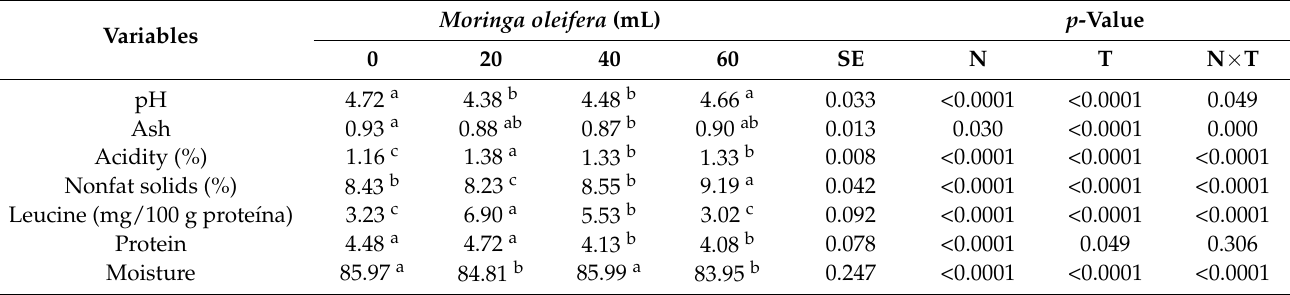
Table 2. Chemical and physical composition of yogurt made from sheep fed with extracts of Moringa oleifera during storage.